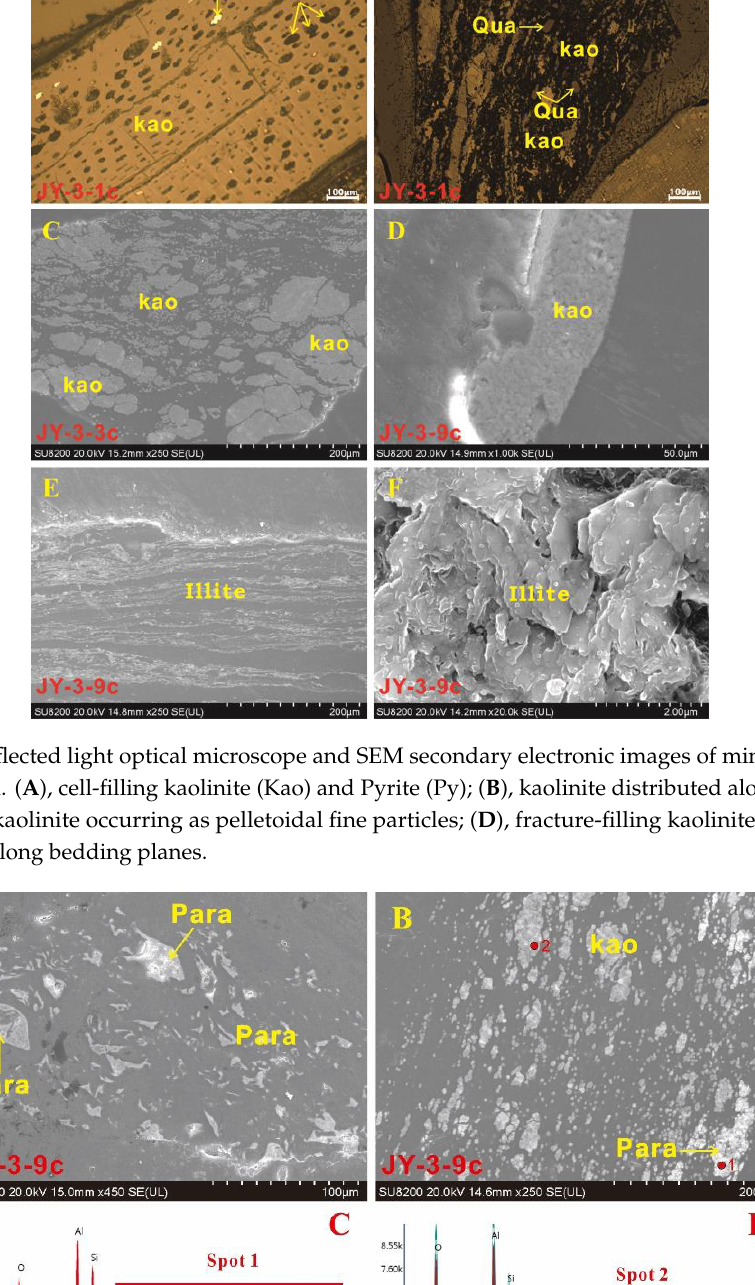
Figure 3. Identification of the well-ordered structure of kaolinite and siderite (contains Mg) in the X-ray diffractogram of sample JY-3-2c.